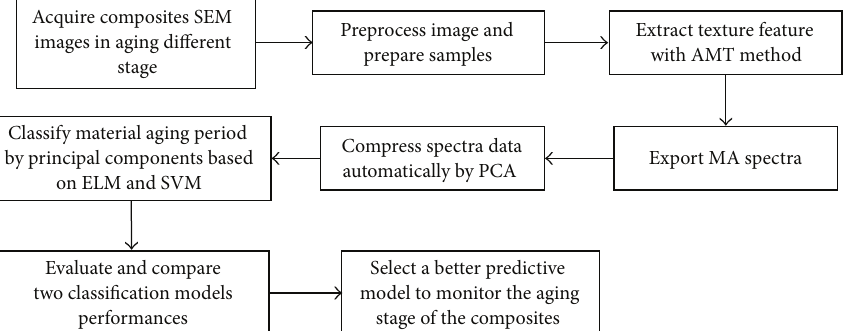
Figure 4: System overall diagram of texture feature extraction and classification of SEM images of the